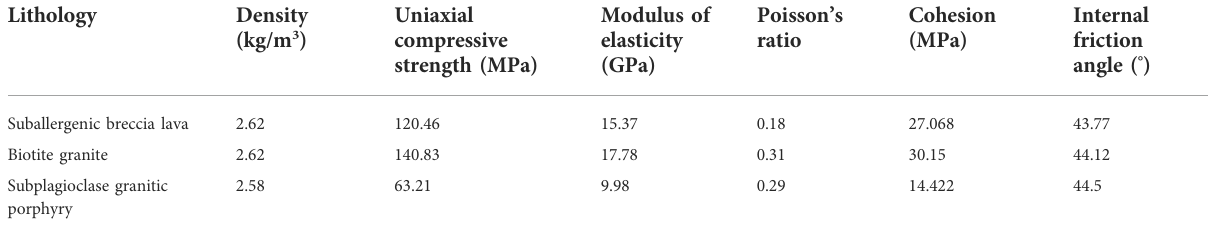
TABLE 2 Mechanical parameters of intact rock.